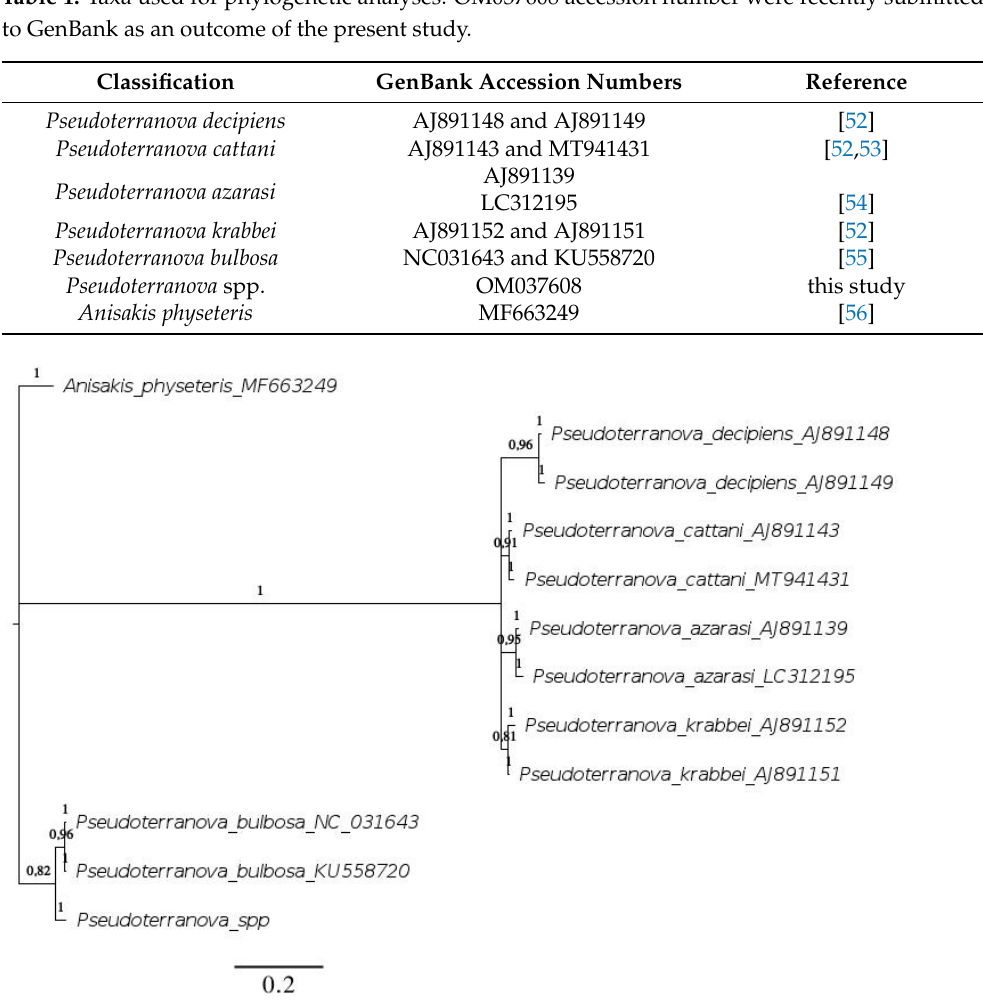
Table 1. Taxa used for phylogenetic analyses. OM037608 accession number were recently submitted